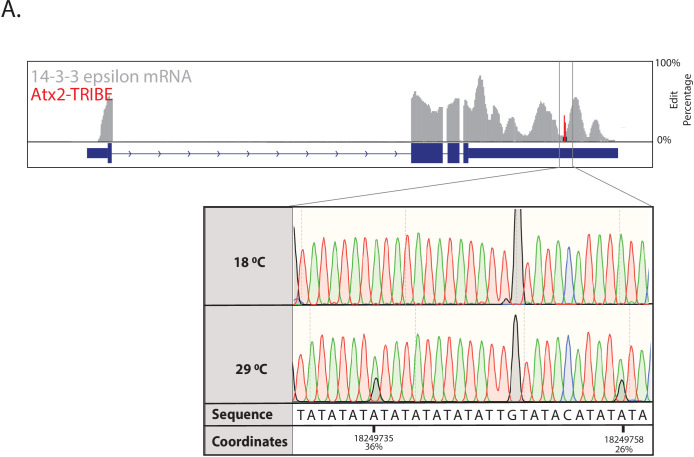
An example of a gene, 14-3-3 epsilon, showing multiple edits specifically in the exons.Red lines show the edit percentages at the different modified nucleotides with respect to the total mRNA present at a given moment of time.